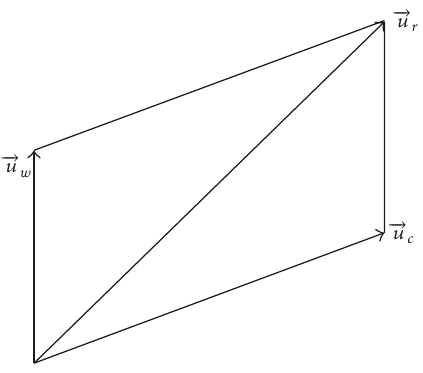
Figure 2: Velocity vector of oil slick